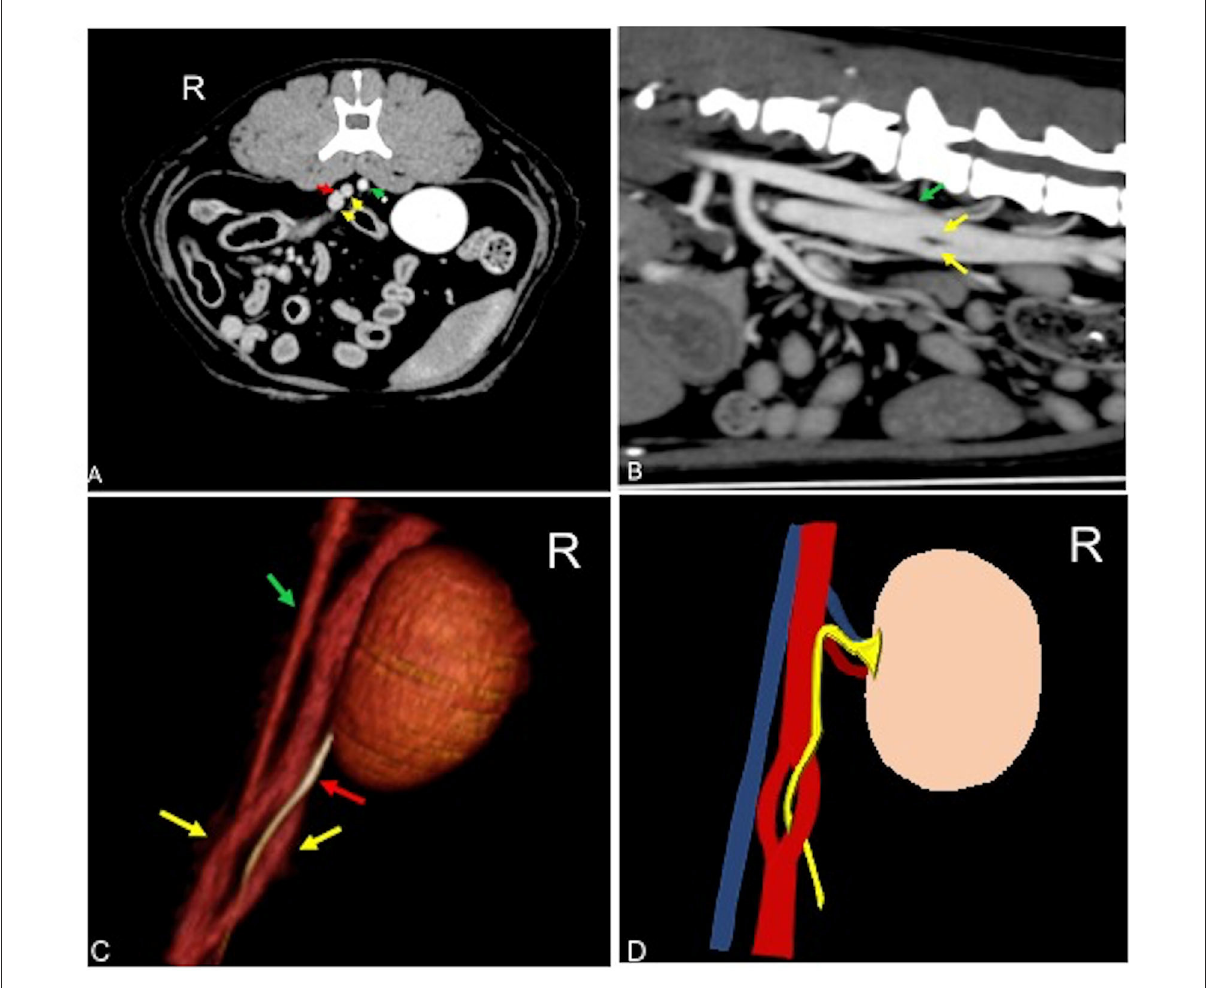
FIGURE1 Postcontrast computed tomographic of mid abdomen in transverse (A) , sagittal (B) , volume rendering image in a right-dorsal view (C) , and schematic representation of the malformation (C) showing the CVC venous ring (yellow arrow) described as double barrel-gun sign with the right ureter (red arrow) passing through it. The venous malformation is normally located right-ventral to the aorta (green arrow). Soft tissue reconstruction (window level: 40 HU, window width 400 HU) and a slice thickness of 1.25mm were used. In (D) , the aorta is blue, the CVC is red, and the ureter is yellow. R,